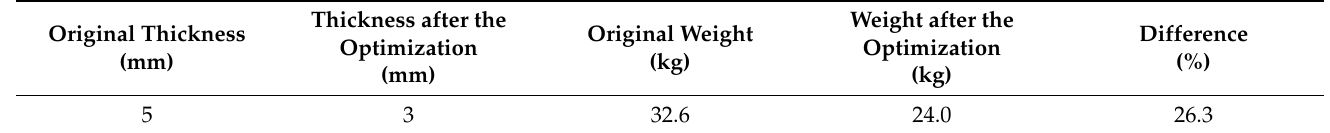
Table 7. Comparison of the thickness and weight of frame parts using original steel S235JR solution and stronger S355J0 steel.